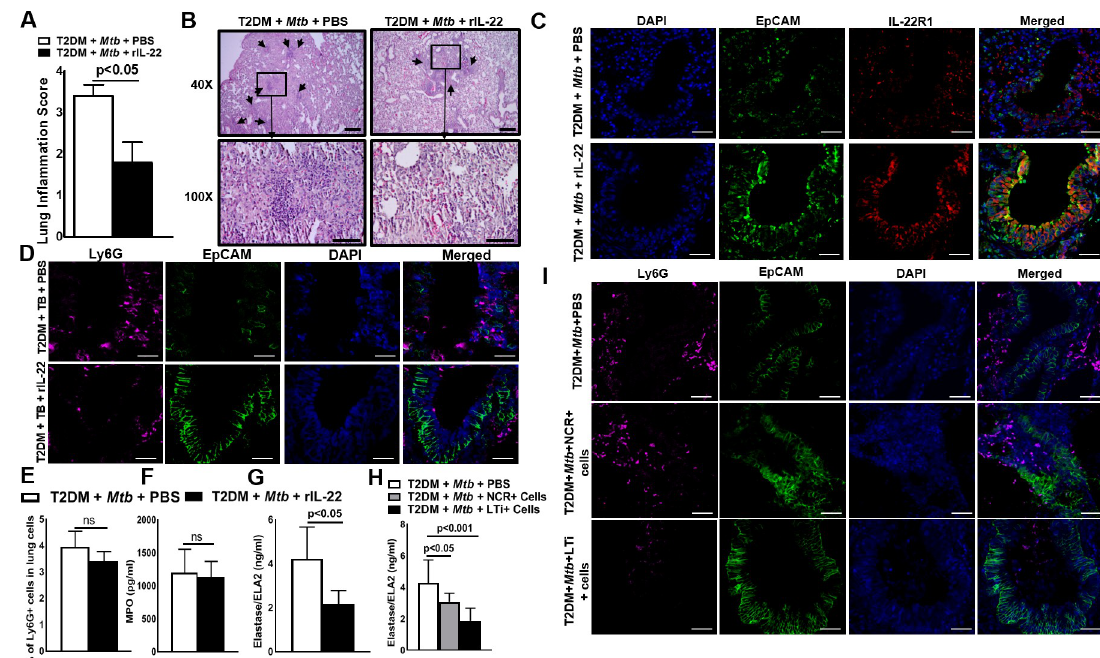
Fig 6. IL-22 reduces the severity of lung inflammation and neutrophil-mediated damage of lung epithelial cells in Mtb -infectedT2DM mice. One month after the induction of diabetes, T2DM mice were infected with ~100 CFU of aerosolized Mtb as shown in Fig 1 and described in the methods section. Five months after Mtb infection, T2DM mice were treated intravenously with either recombinant IL-22 (100 ng/kg body weight, twice weekly) or PBS. (A) After one month of recombinant IL-22 treatment, the lungs were isolated and formalin fixed. Paraffin-embedded tissue sections were prepared, and hematoxylin and eosin staining was performed. Lung inflammation scores were quantified by morphometric analysis. (B) Representative hematoxylin and eosin-stained lung tissue sections in multiple fields (at 40X and 100X) are shown. (C) Paraffin-embedded tissue sections were analyzed by confocal microscopy to determine the colocalization of EpCAM- positive cells (green) and IL-22R1+ cells (red). (D) Paraffin-embedded tissue sections were analyzed by confocal microscopy to determine the accumulation of the Ly6G+ cells (magenta) near the EpCAM+ epithelial cell lining (green). (E) The frequencies of Ly6G+ lung cell populationswere determined by flow cytometry staining at 1 month after recombinant IL-22 treatment. (F-G) One month after PBS or recombinant IL-22 treatment, lung homogenates of the Mtb -infectedT2DM mice were collected, and the levels of (F) myeloperoxidase (MPO) and (G) elastase were measured by ELISA. (H and I) T2DM (CD45.2, C57BL/6 background)mice were infectedwith 50–100 CFU of aerosolized Mtb .Five months after Mtb infection, 0.5 x 105 NCR+ or LTi+ pooled cells (from spleen, lung, liver, lymph nodes and mucosal sites) from CD45.1 mice (C57BL/6) were adoptively transferred via tail vein injection (recipient CD45.2 Mtb-infected T2DM mice). (H) Elastase levels in the lung homogenate were measured by ELISA. (I) Ly6G+ cell accumulation near EpCAM+ cells (epithelial cell lining) in the lungs of ILC3- or PBS-treatedMtb-infected T2DM mice was analyzed by confocal microscopy. A representative immunofluorescence image is shown. Five mice per group were used. The mean values, SDs and p-values are shown.